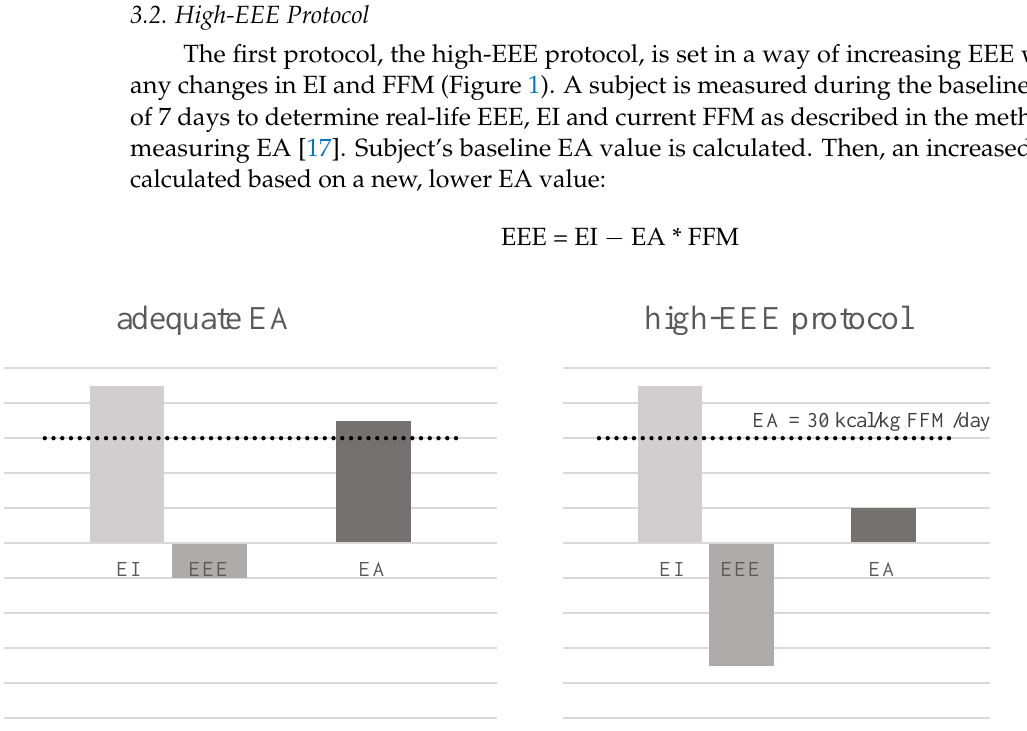
Figure 1. A schematic representation of high-EEE protocol. EI remains identical, while EEE is increased in a way to reach a favorable EA.